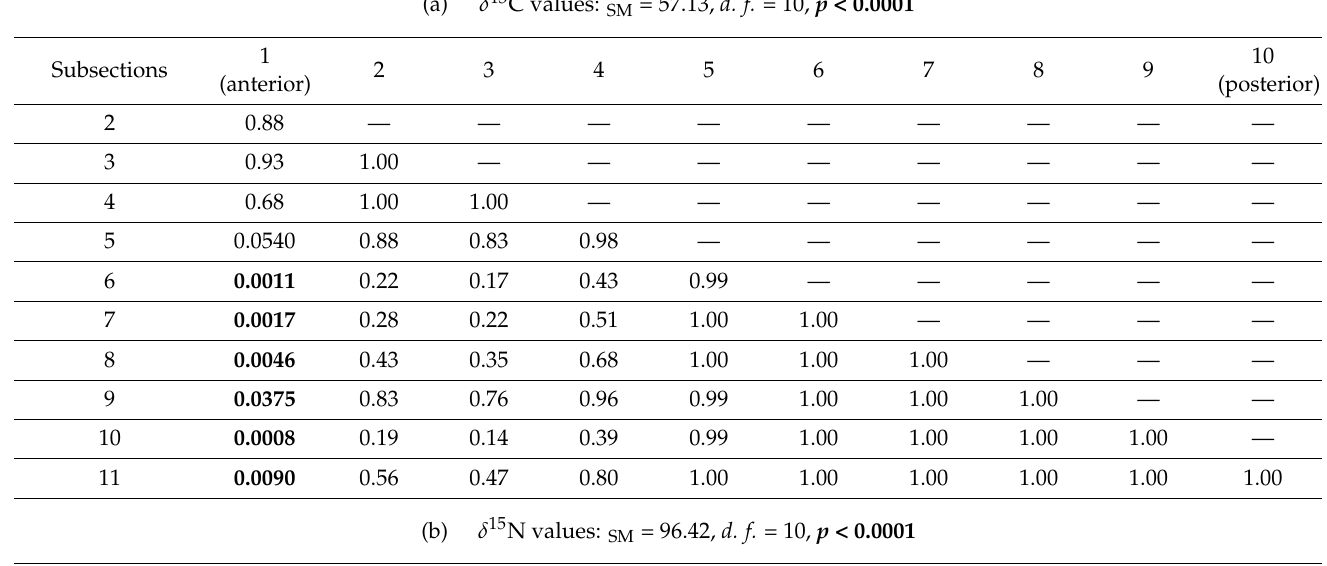
Table 3. Comparison of (a) δ 13 C and (b) δ 15 N values, and (c) estimated trophic level among different upper beak subsections in Gonatus fabricii , using the Skillings–Mack test with the Nemenyi post hoc test. Significant p -values are in bold . TL: estimated trophic level, —: not